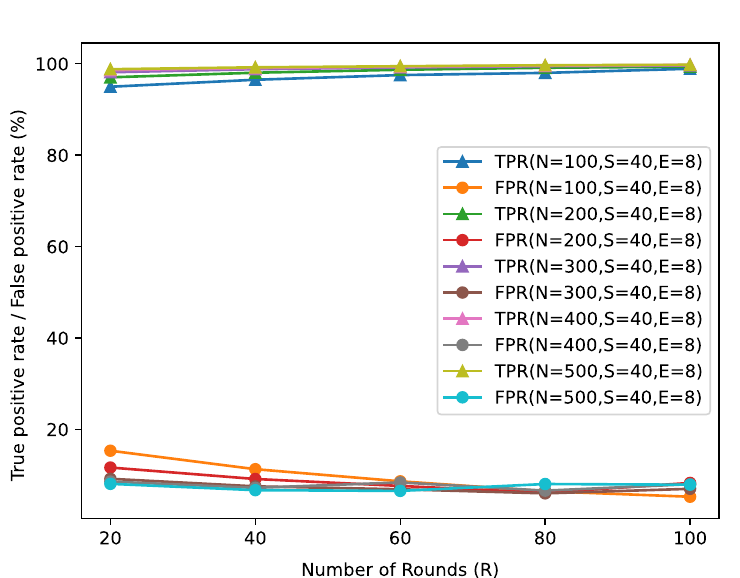
Fig. 4 Effects of the number of normal nodes N on detection